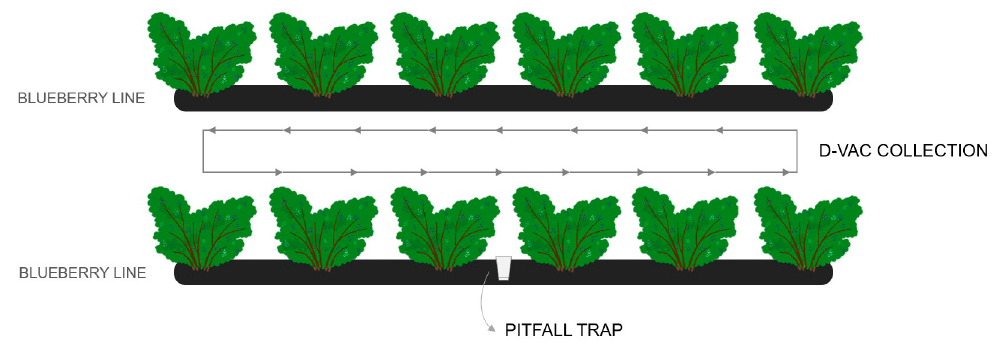
Fig 2. Visual representation of the arthropod sampling